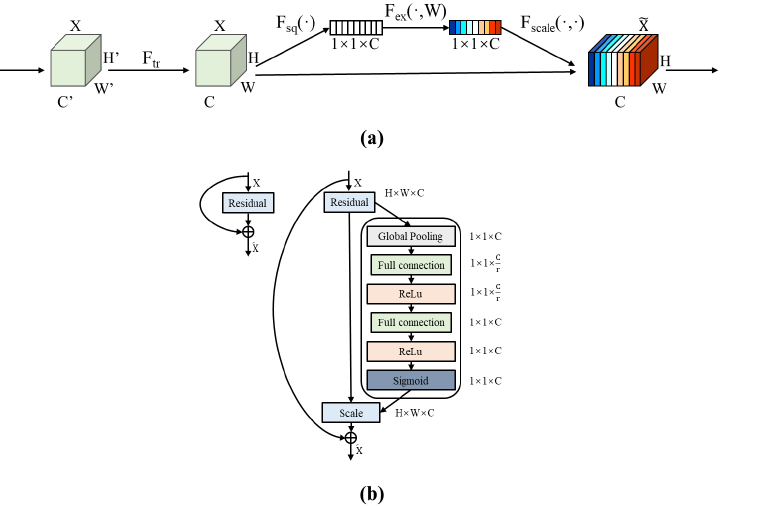
Figure 4. Structure and embedding scheme of the SE block: ( a ) SE block structure; ( b ) SE block application scheme in ResNet. The SE block mainly contains three processing processes: squeeze, excitation and scale. The output of the previous layer is the processing object, and a 1 × 1 convolution operation is performed first to obtain the feature map.